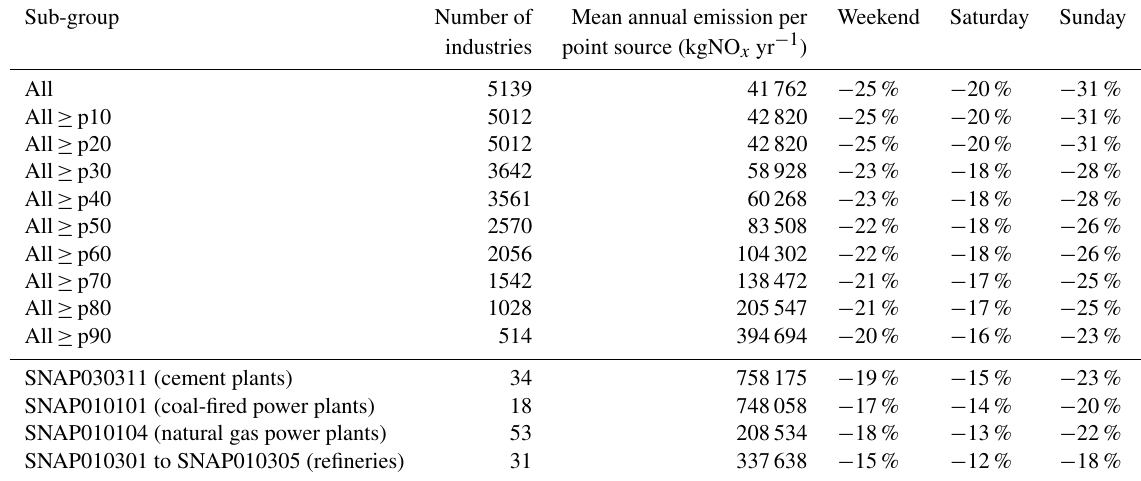
Table G3. Mean TROPOMI-based TrC-NO 2 weekend effect above different groups of industrial point sources across Spain. p X here cor- responds to the X th percentile of the mean emission of the different industrial point sources. Specific industrial activities were grouped according to the Selected Nomenclature for Air Pollution (SNAP) classification